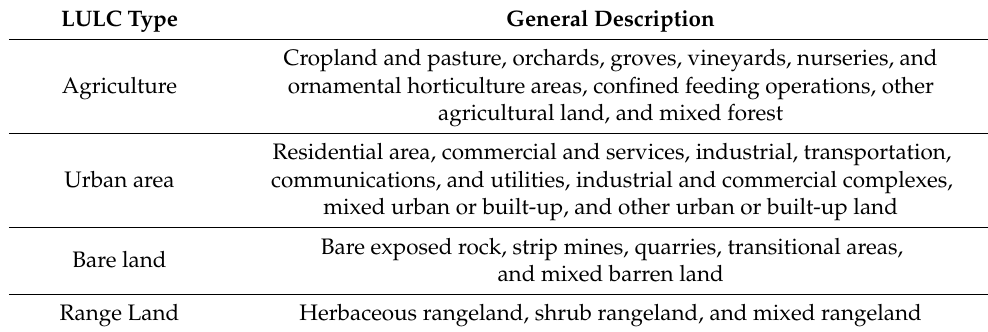
Table 2. Description of LULC classes that have been identified according to Anderson et al. [30]. LULC